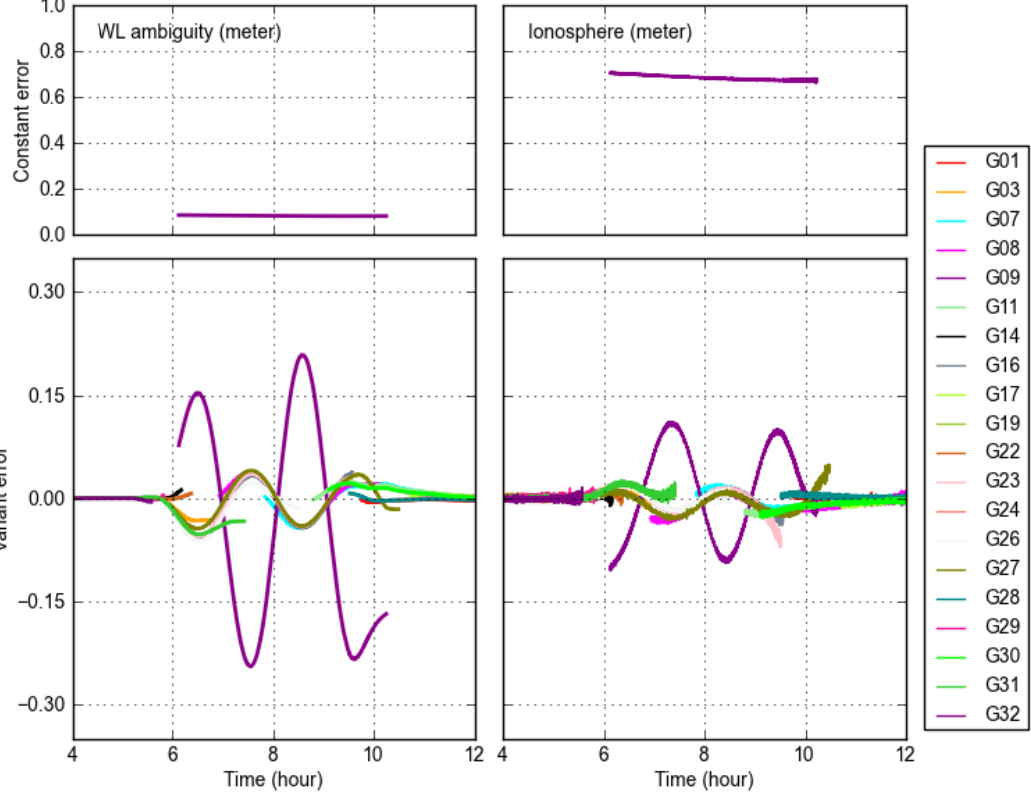
Figure 13. Differences of GB WL ambiguities (left) and ionospheric delays (right) with and without the simulated errors (constant bias—top row; time-variant errors—bottom row) added to OC product of PRN 09 at GODN.